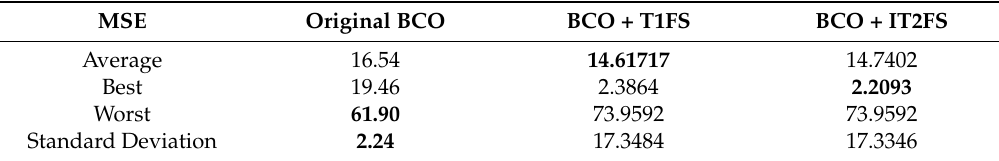
Table 9. Comparison of results of the plant with noise for the